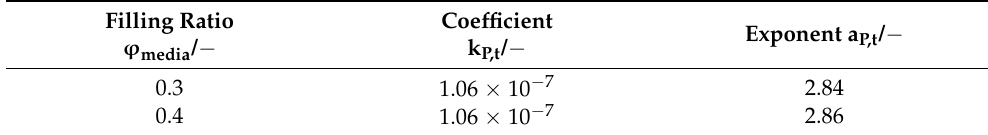
Table 5. Variables for model equation (Equation (12)) to describe the total power input based on rotational speed n (in min − 1 ).